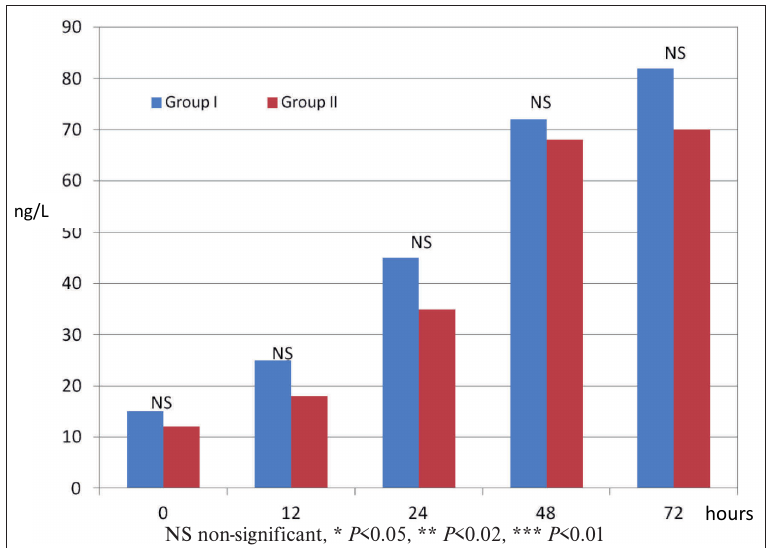
Fig. 5. Serum CRP before and after surgery in Group I and Group II (mean